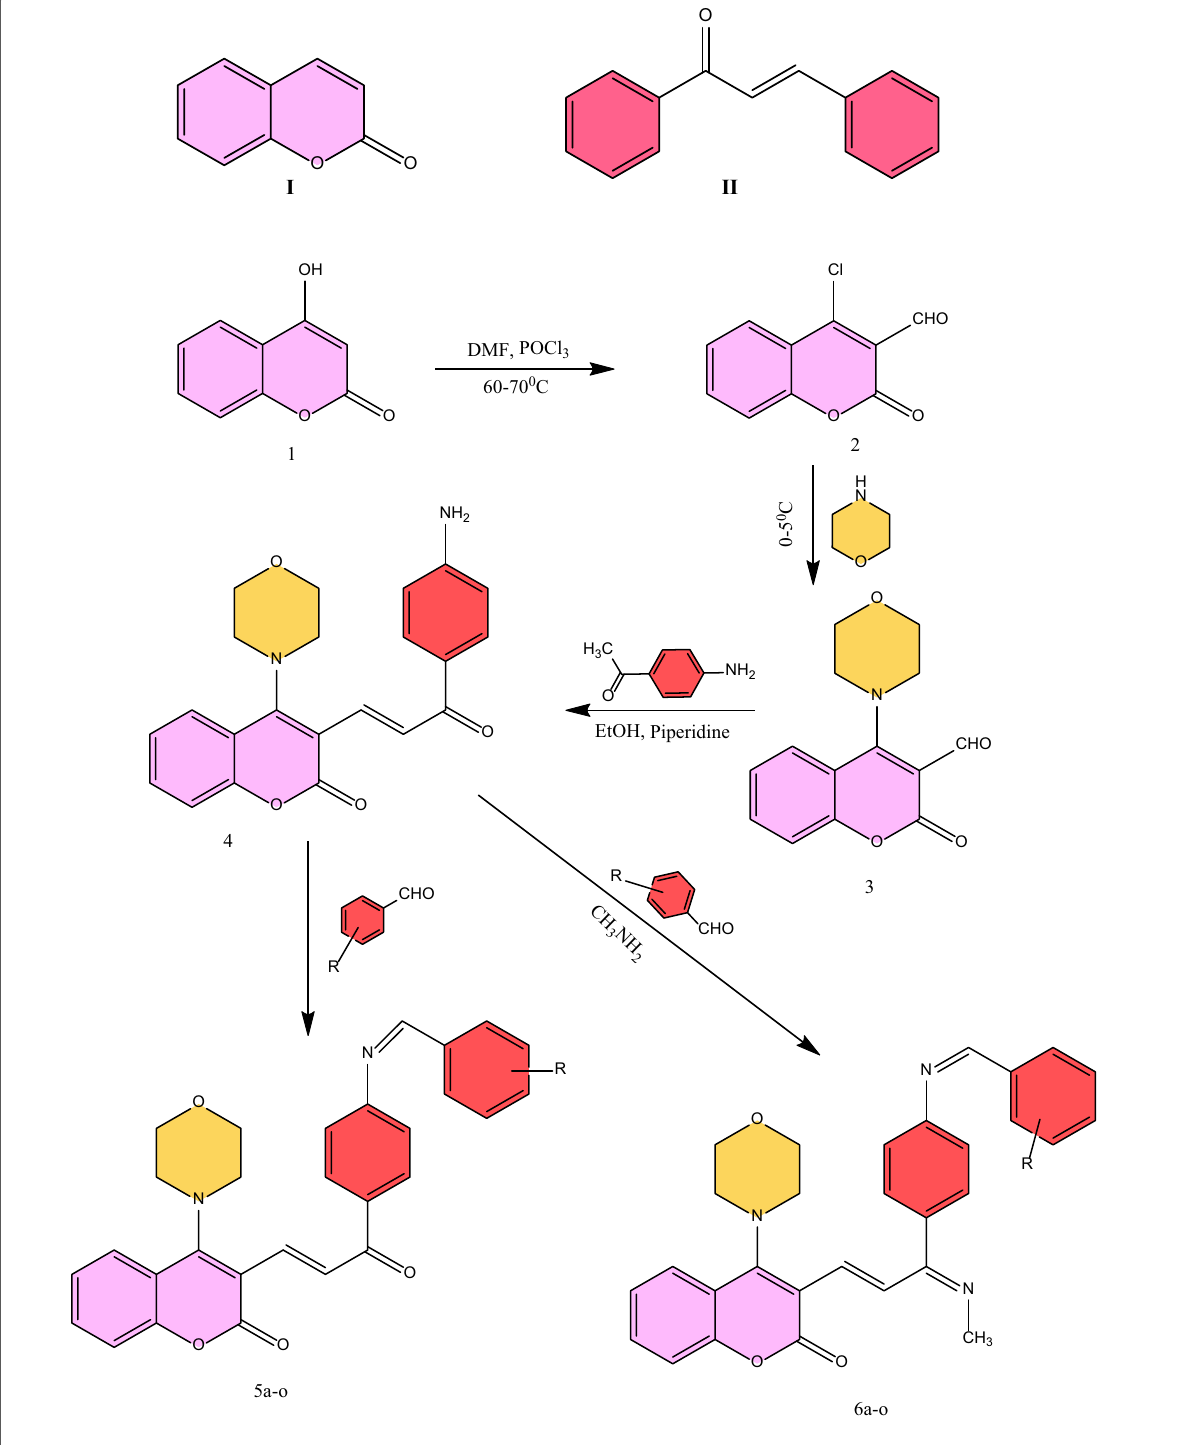
Scheme 1 Reaction scheme for the synthesis of coumarin-chalcone